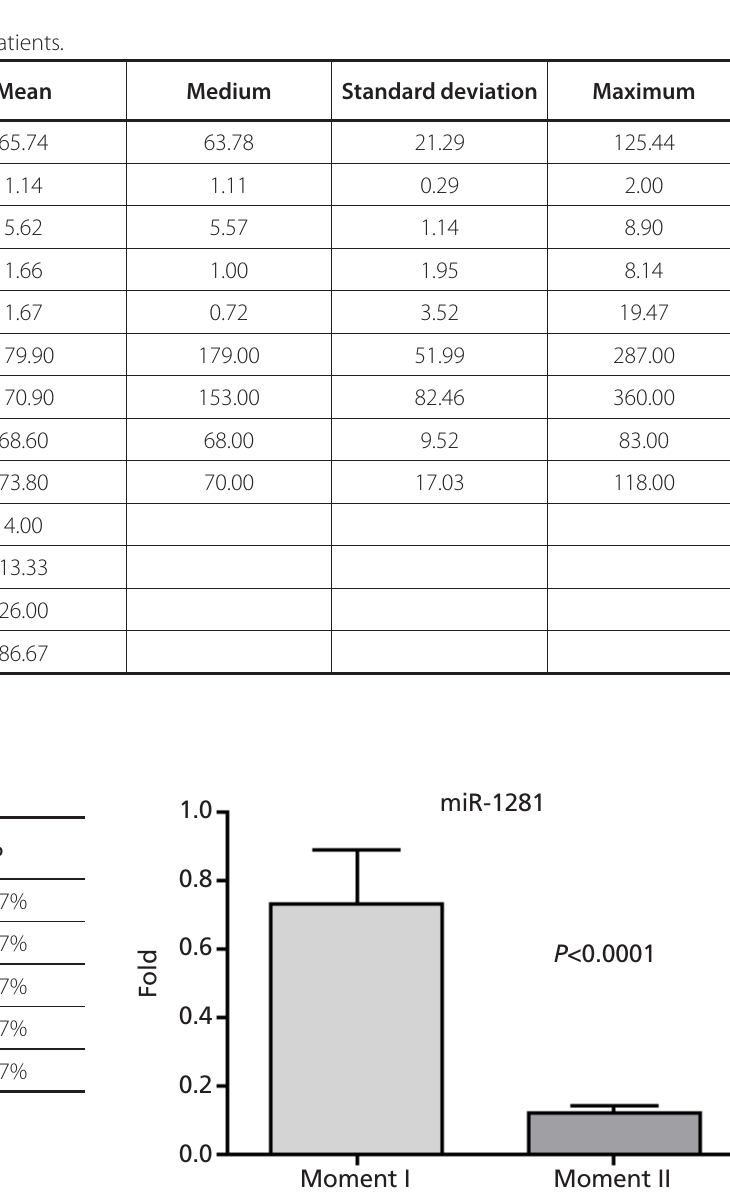
Fig. 1 - Micro ribonucleic acid (MiRNA)-1281 expression before and after endovascular aneurysm repair (EVAR). Moment I – before EVAR. Moment II – six months after